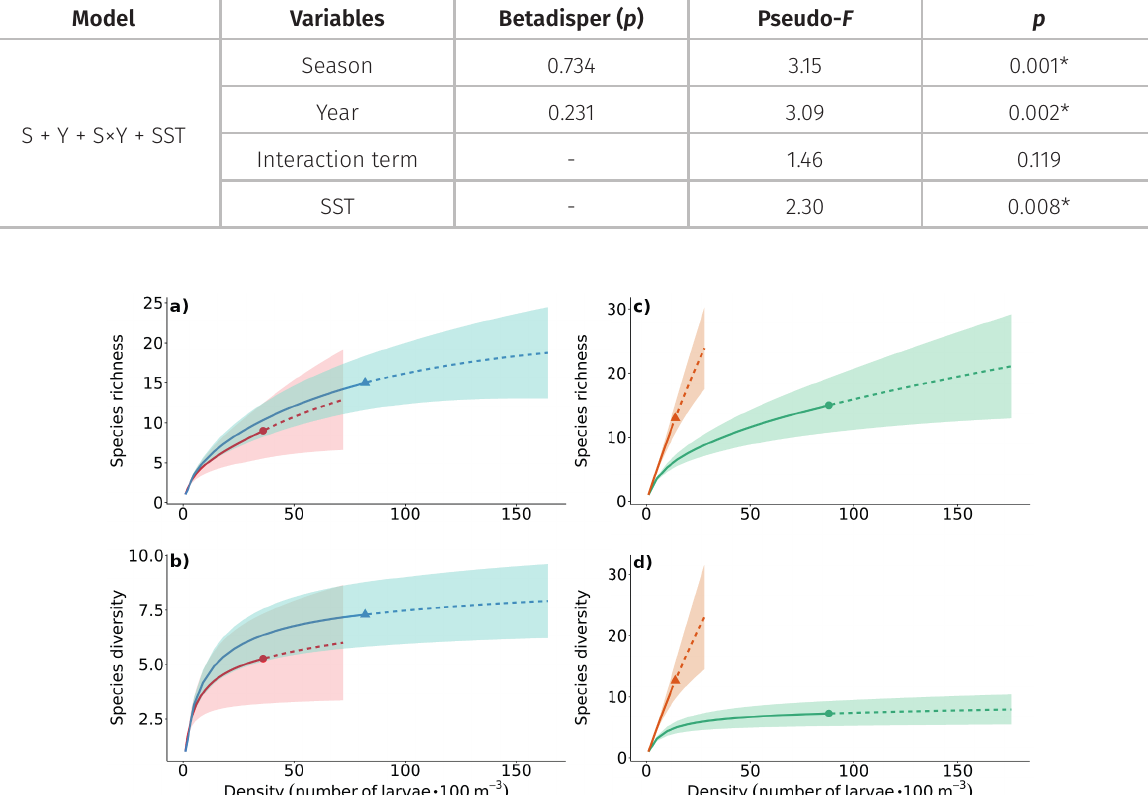
Table III. Results of the PERMANOVA model testing the effects of Season (S), Year (Y), their interaction (S×Y),